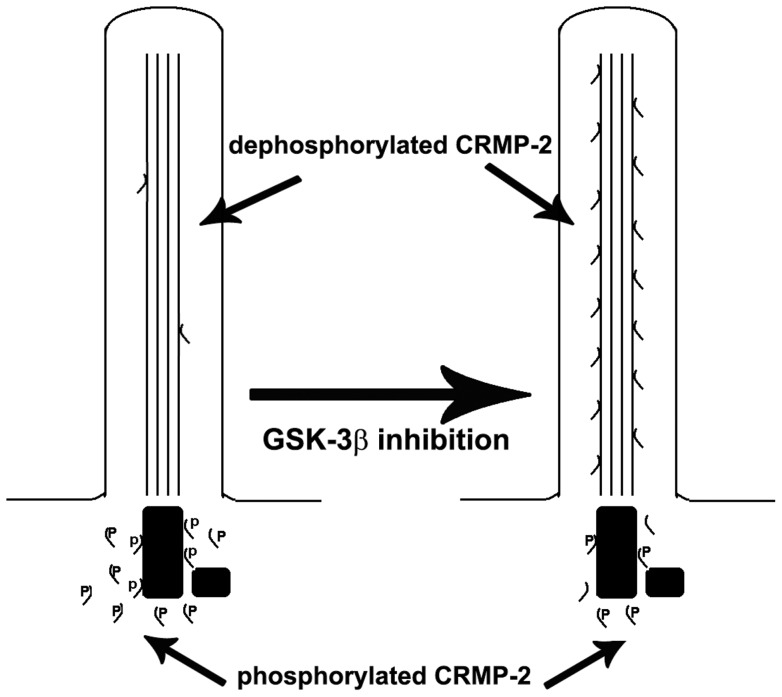
Model for regulation of CRMP-2 localization to primary cilia.The model schematically presents that the majority of CRMP-2 in normal serum-starved cells is phosphorylated by GSK-3β and resides at the basal body. After GSK-3β inhibition or mutation of CRMP-2 GSK-3β phosphorylation sites, CRMP-2′s presence in the primary cilium is enhanced.